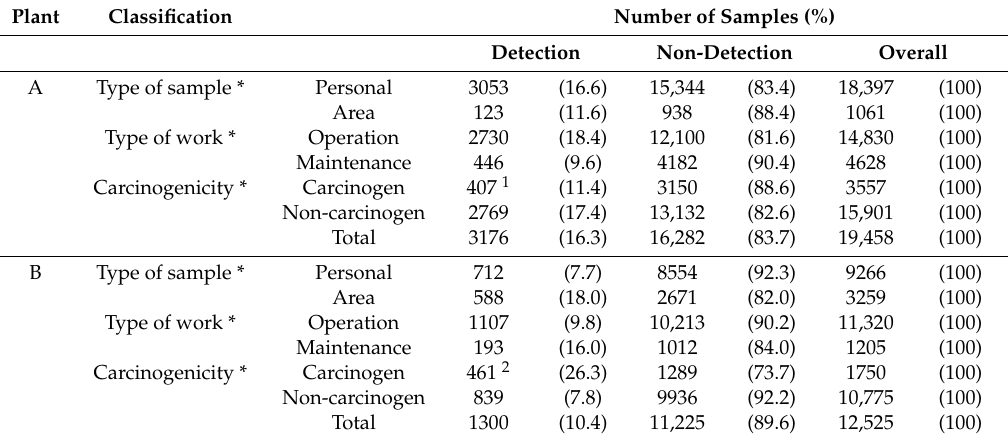
Table 1. Summary of the review of work environment monitoring results from 2012 to 2014.